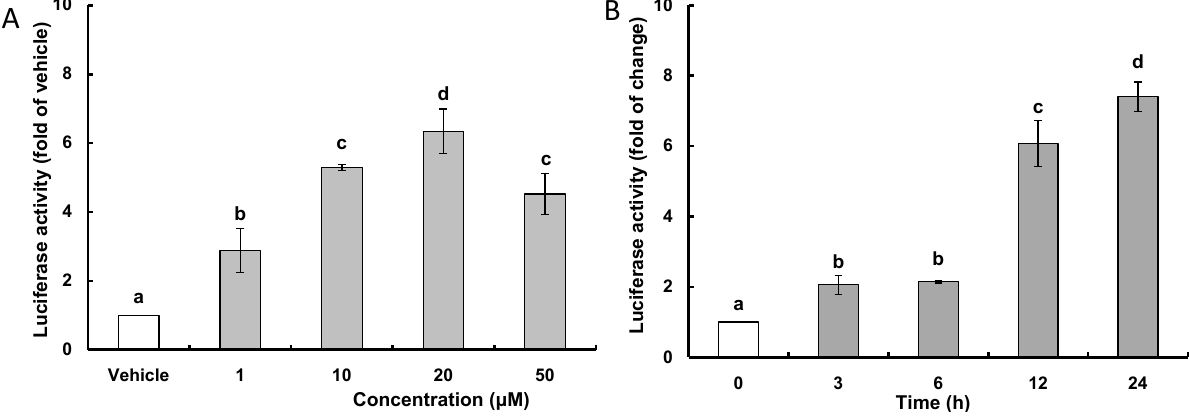
Figure 1. CAPE (caffeic acid phenethyl ester) increases ARE (antioxidant response element) luciferase activity. ( A ) After HepG2 cells were subjected to 1–50 μM CAPE for 12 h, ARE luciferase activity was determined and normalized to vehicle; ( B ) Time-course experiment was carried out for the indicated times using 20 μM CAPE and normalized to time zero. Data are expressed as mean ± standard deviation of three individual experiments. Different corresponding letters indicate significant differences at p < 0.05 by Duncan’s test.